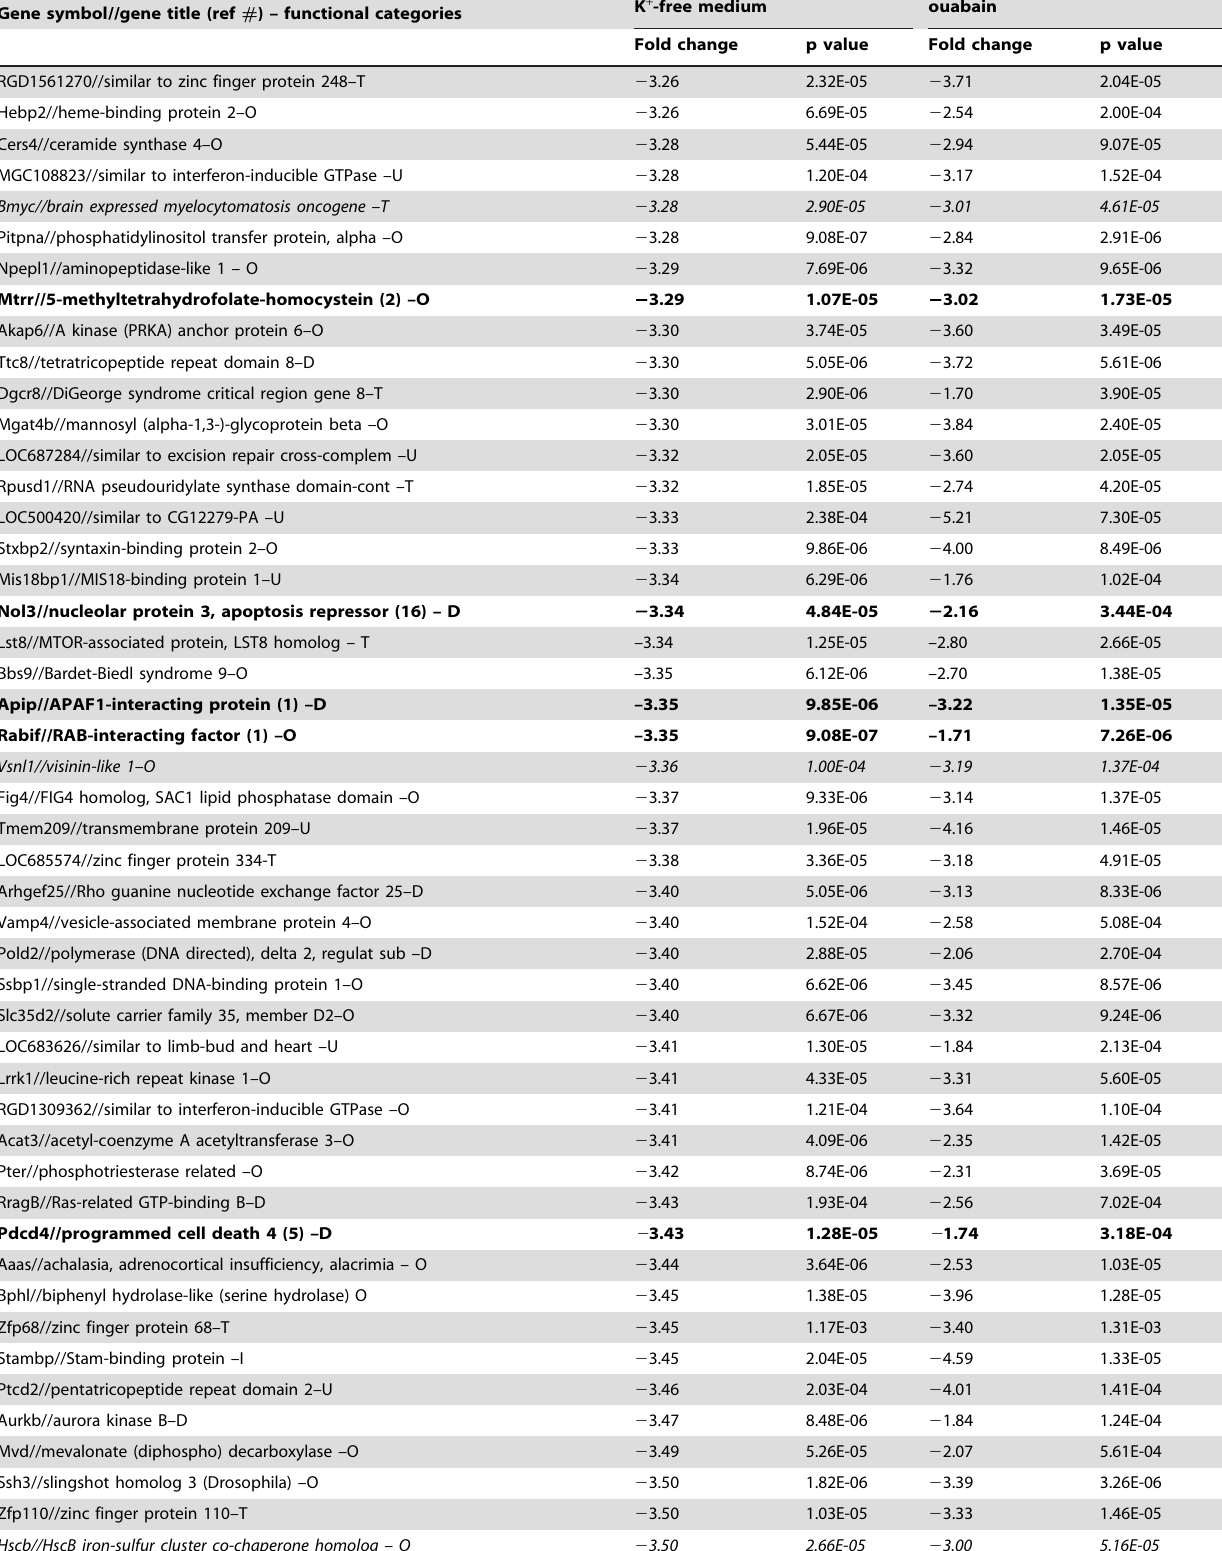
Fig4//FIG4 homolog, SAC1 lipid phosphatase domain